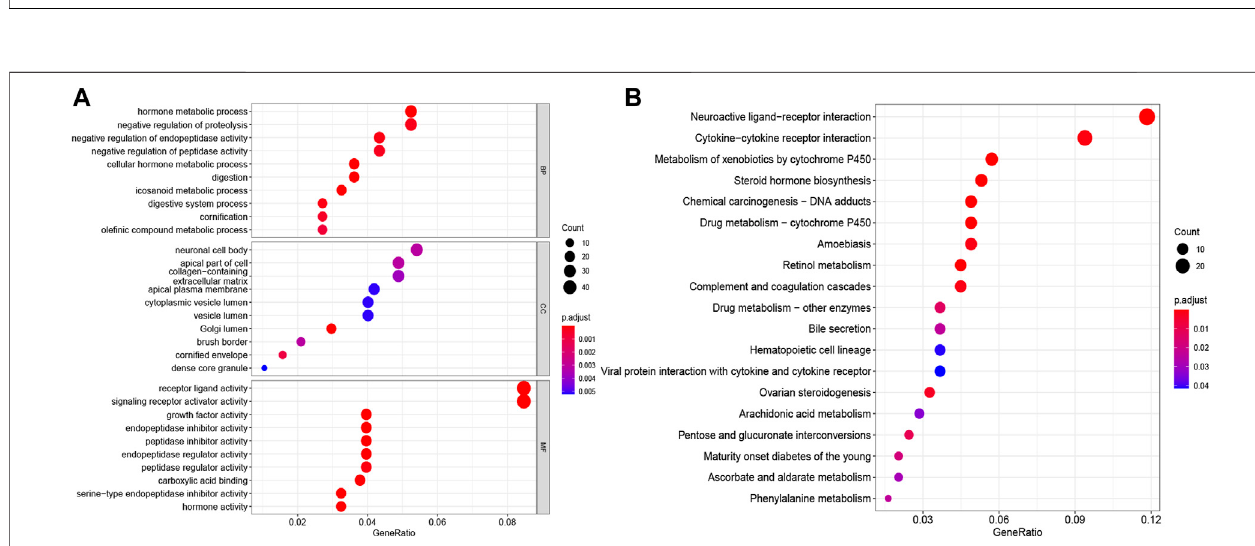
FIGURE 6 | Functional enrichment analyses depending on the signature. The bubble graphs for GO enrichment analysis (A) and KEGG pathway analysis (B) were displayed. The bigger the bubble, the richer the genes, and the darker the red, the more pronounced the difference.